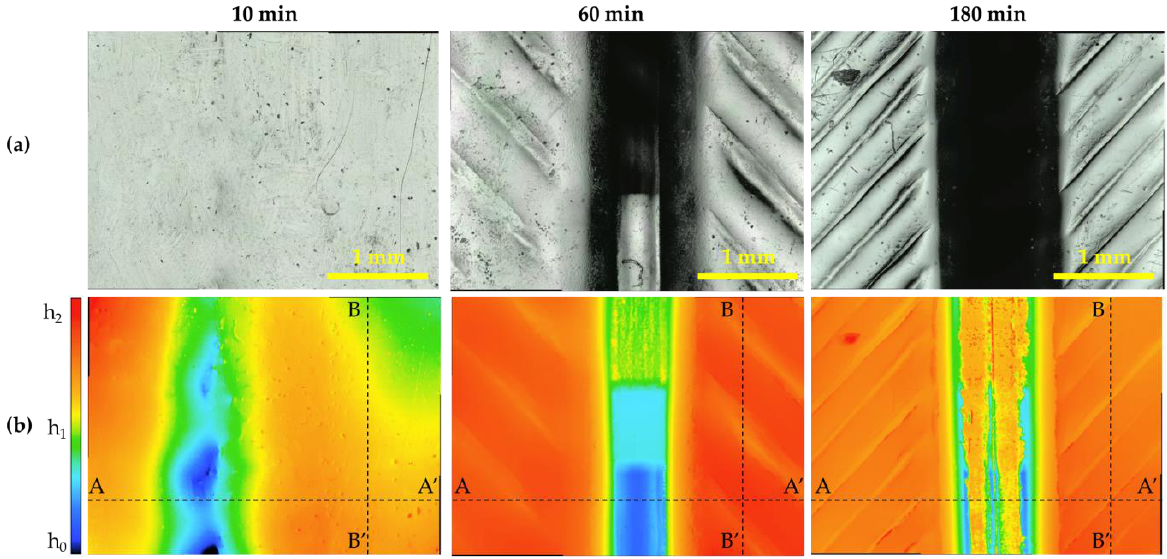
Figure 11. Images of confocal laser scanning microscope as a function of saturation time: ( a ) laser and optical; ( b ) color map for height.